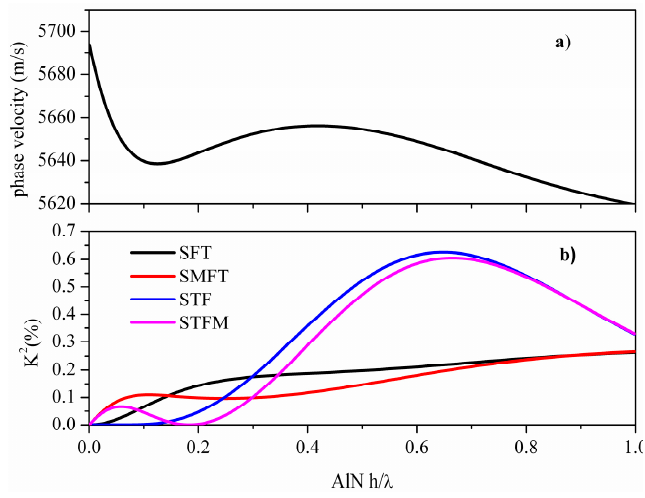
Figure 14. The phase velocity ( a ) and K 2 ( b ) dispersion curves for SAW propagating along the <110>